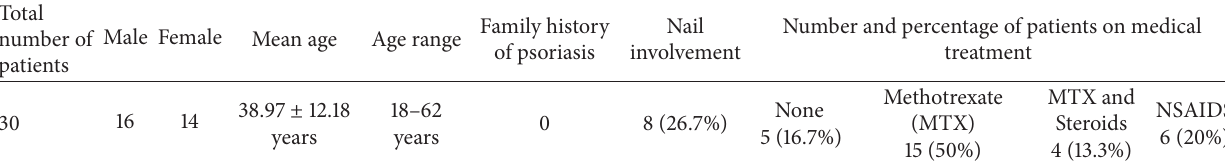
Table 2: Demographic data of the patients.